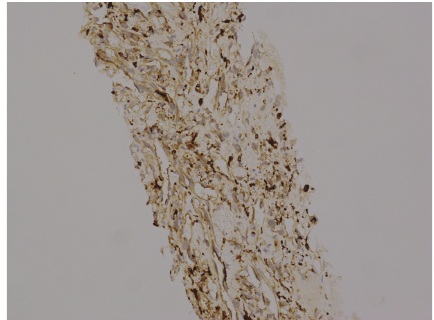
Figure 3: Primary splenic angiosarcoma. Immunohistochemical CD68 staining. 20-fold magnification.